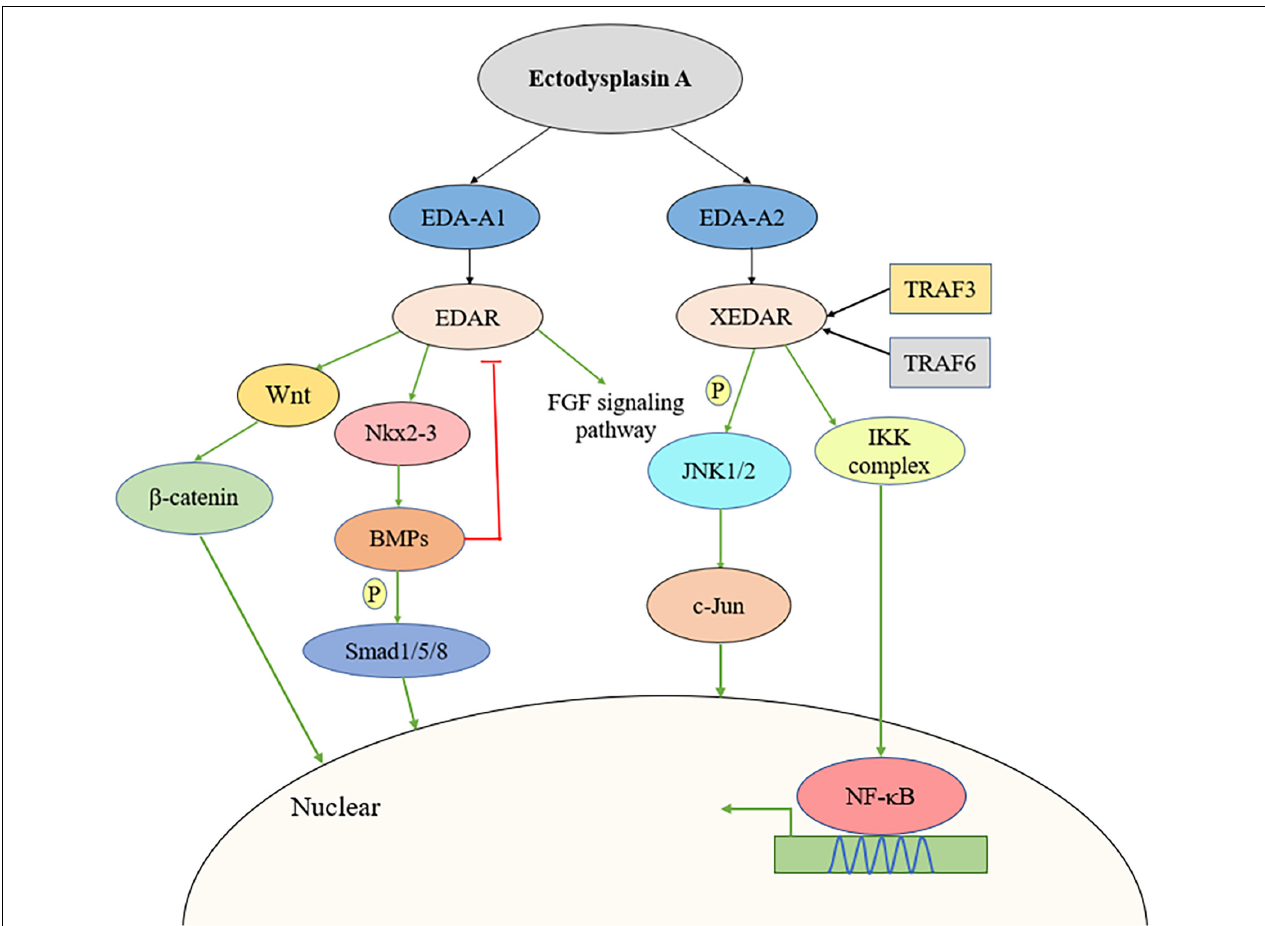
FIGURE 1 | Multiple signaling pathways activated by EDA including Wnt/ β -catenin signaling pathway, JNK pathway, BMP/Smad pathway, and FGF pathway. BMP, bone morphogenetic protein; FGF, fibroblast growth factor; JNK, c-Jun N-terminal kinase.